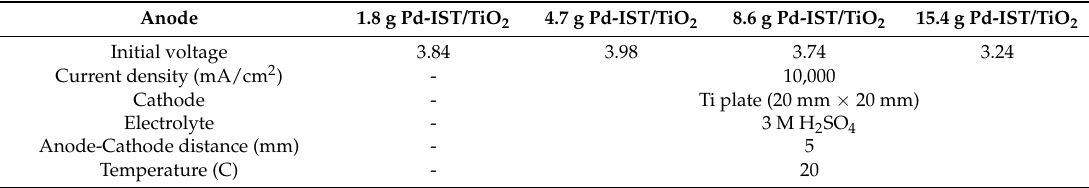
Table 1. Accelerated life test